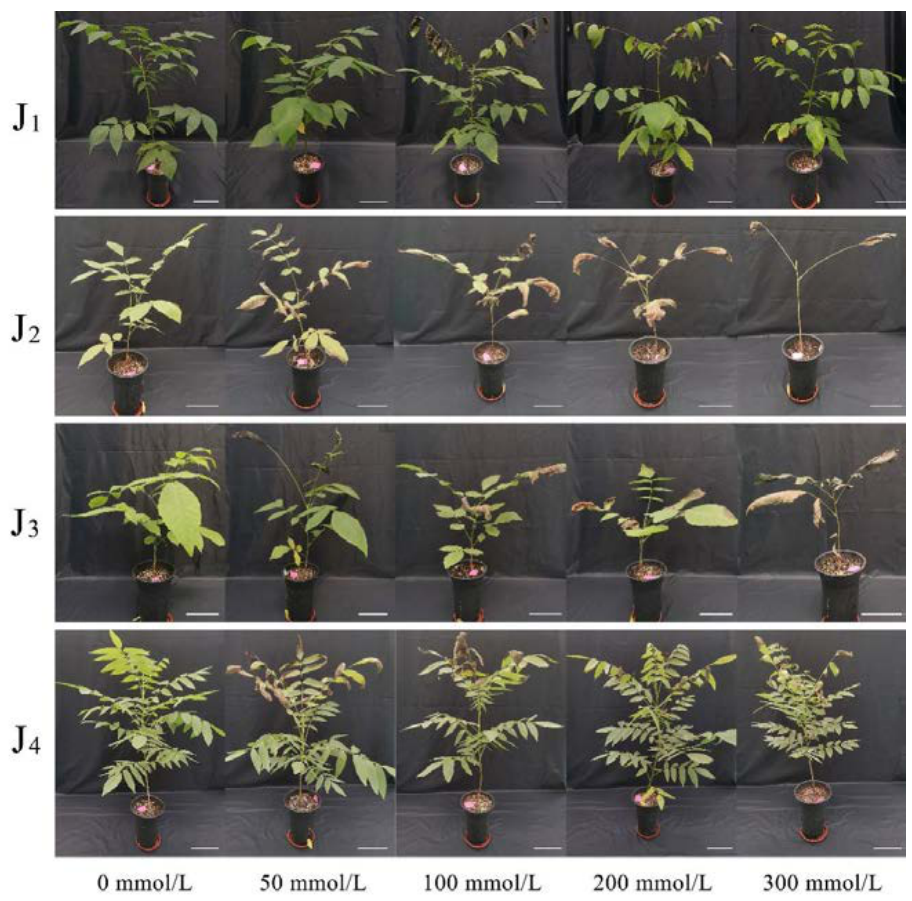
Figure 1. Comparison of the morphological performance of walnut rootstocks under saline irrigation treatment. Four walnut genotypes were grown under different NaCl concentrations (0, 50, 100, 200, and 300 mmol/L) for 28 days. Salt tolerance capacity was estimated after 28 days. Scale bar: 15 cm.